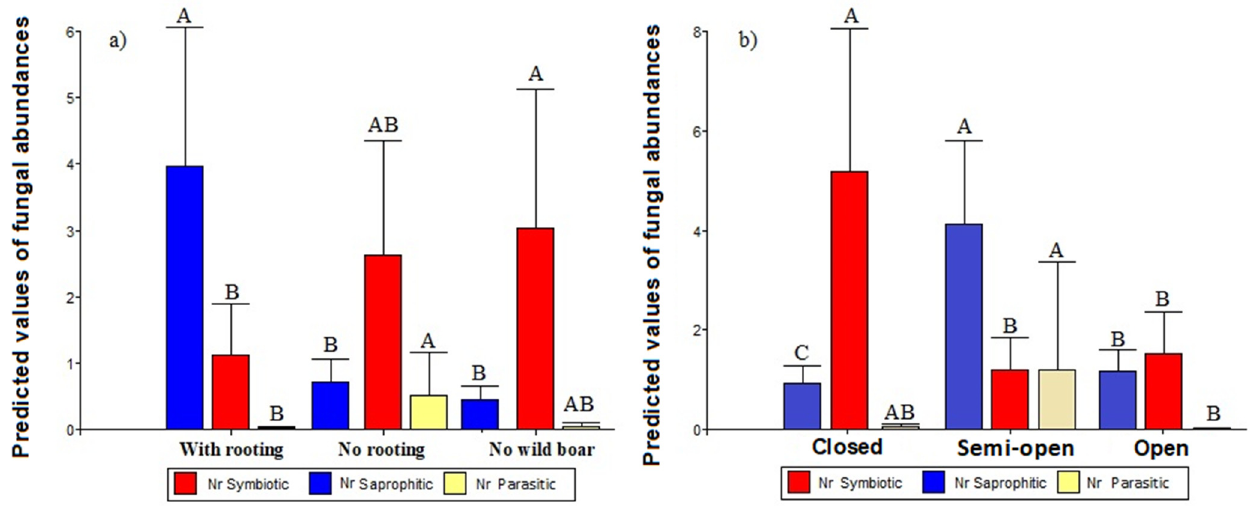
Figure 4. Predicted values of the abundance of fungal sporocarp guilds for each treatment ( a ): wild boar (with rooting), wild boar (no rooting) and no wild boar areas and each forest type ( b ). Bars indicate the standard error. Different letters indicate significant differences among groups according to Fisher’s LSD post-hoc tests ( p < 0.05). Nr = Number of sporocarps per plots.